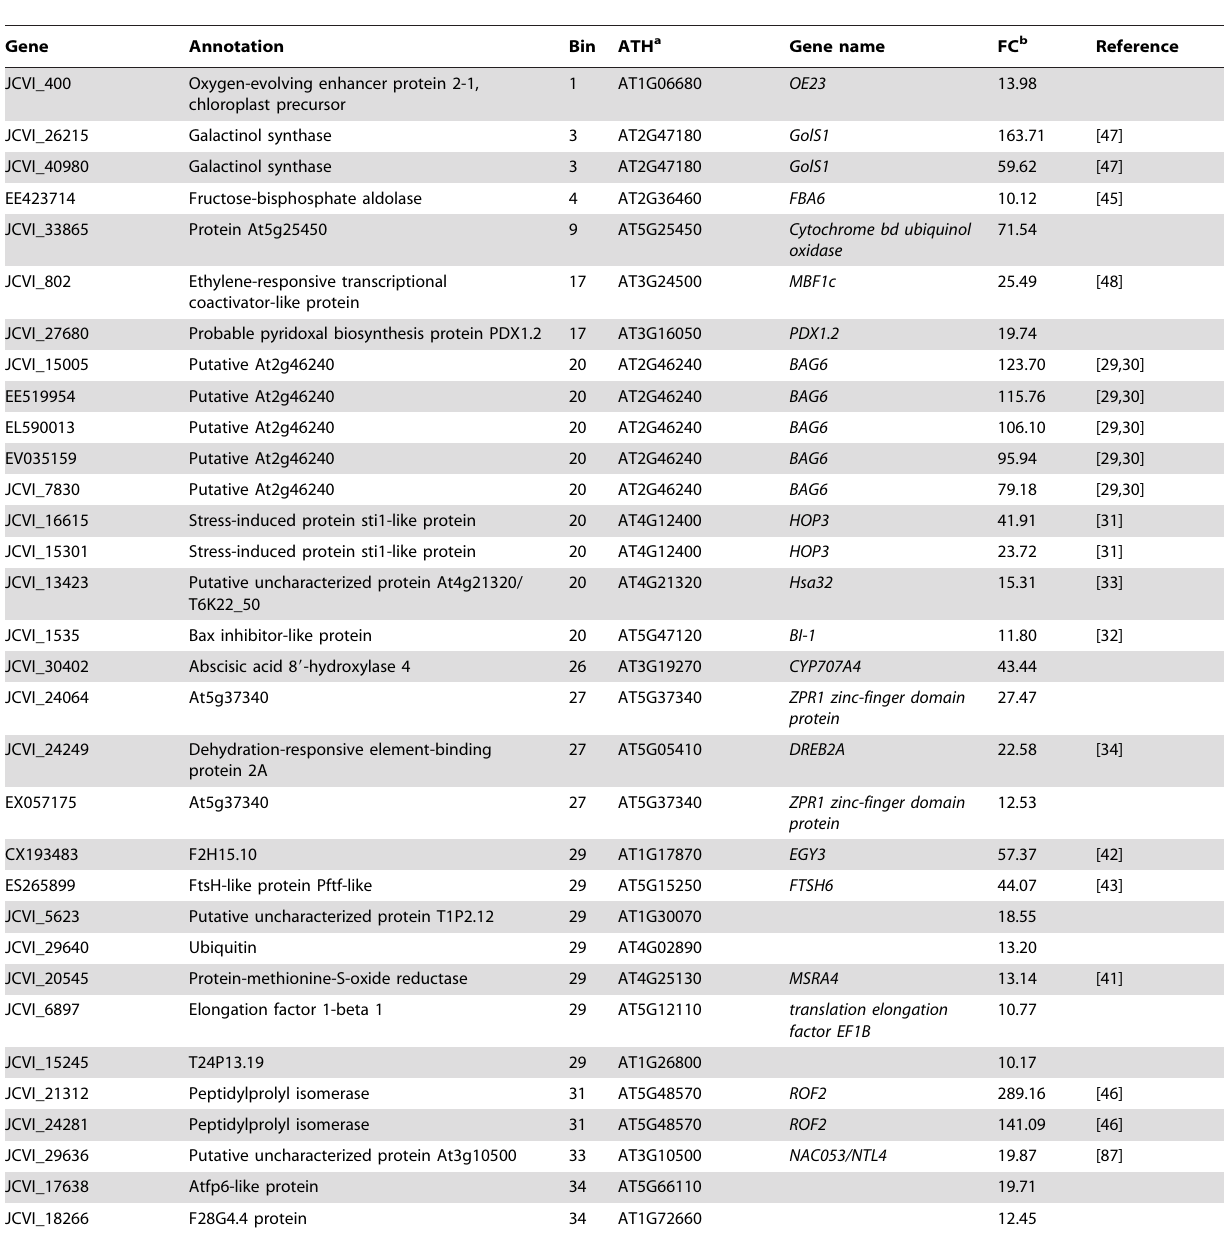
Table 1. List of genes ( Hsf and Hsp genes excluded) exhibiting more than 10-fold changes in expression in both the SW and seeds (Group